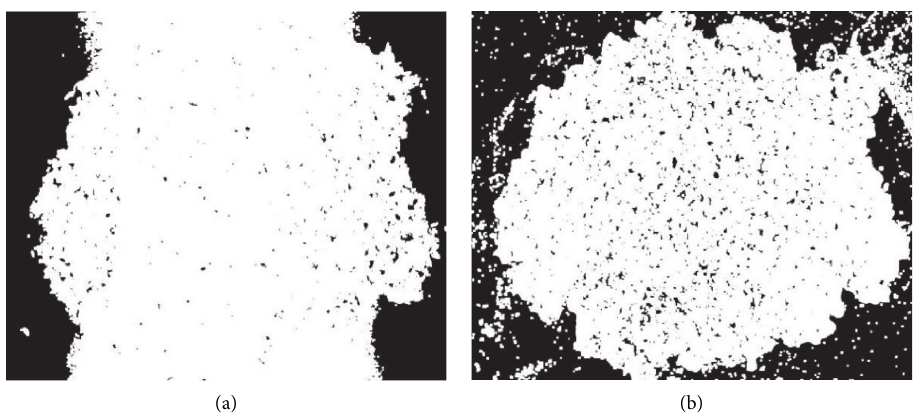
Figure 7: (a) Figure 3 processed by expansion. (b) Figure 6 processed by expansion.